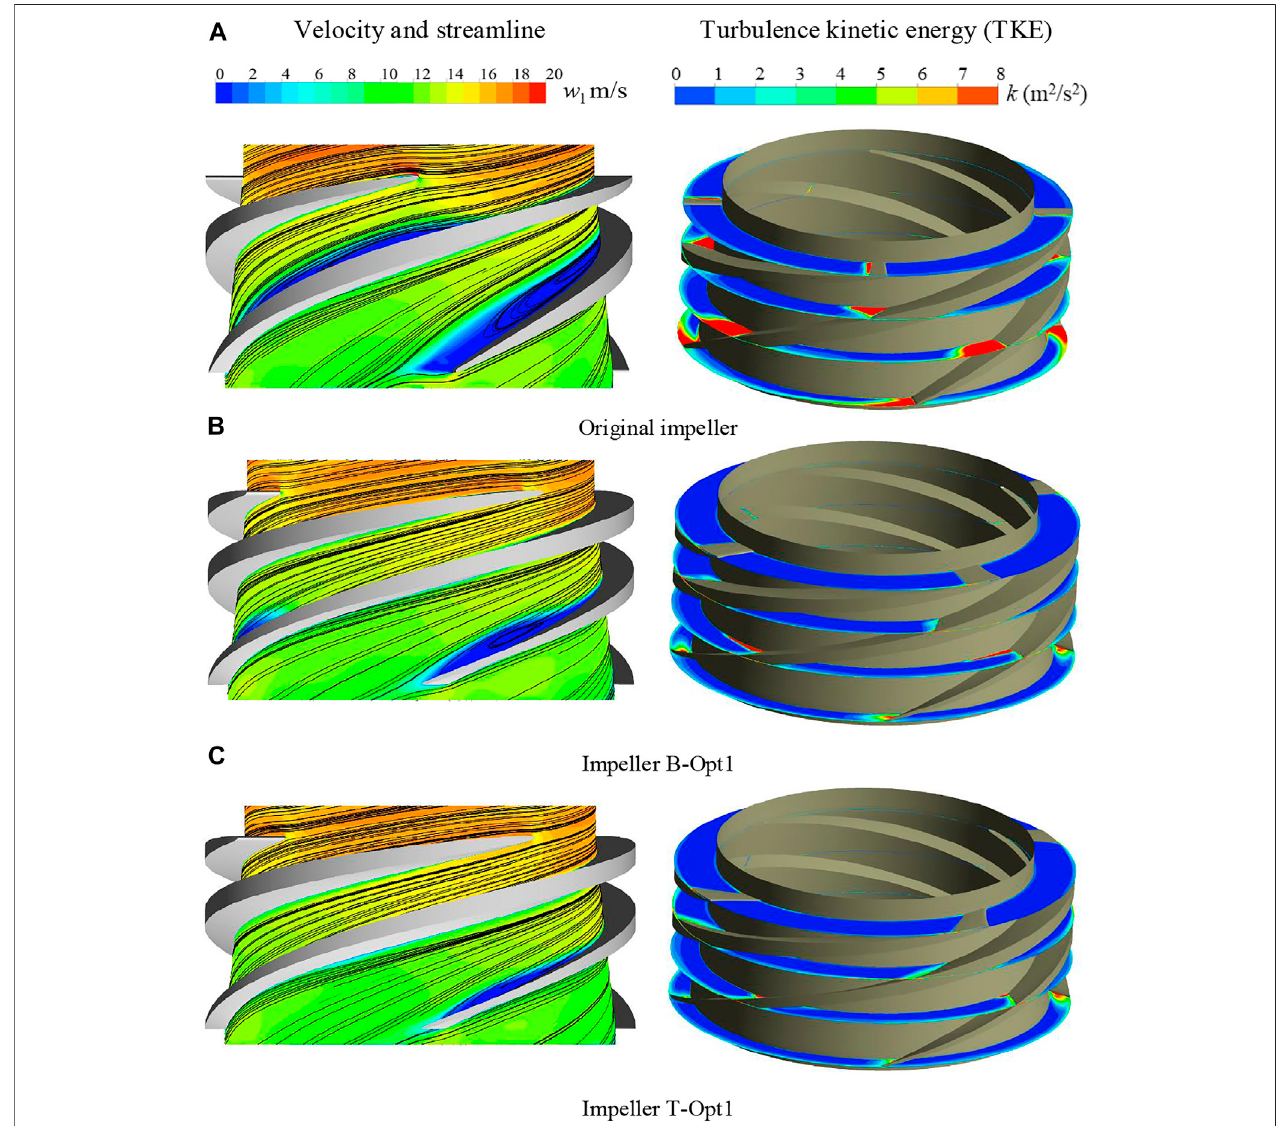
FIGURE 14 | Velocity and streamline of liquid in impeller (span = 0.1). (A) Original impeller. (B) Impeller B-Opt1. (C) Impeller T-Opt1.